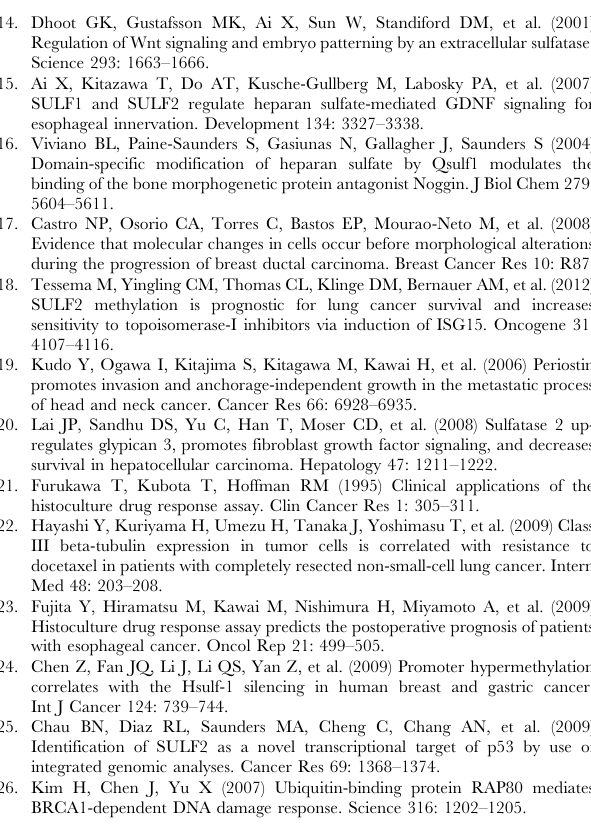
Figure S1 The RT-PCR amplification curves of SULF2M and SULF2U. The red curve stands for amplification of SULF2M, and the blue curve stands for amplification of SULF2U. Figure S1a shows the amplification curves of sample with SULF2M; Figure S1b shows the amplification curves of sample with